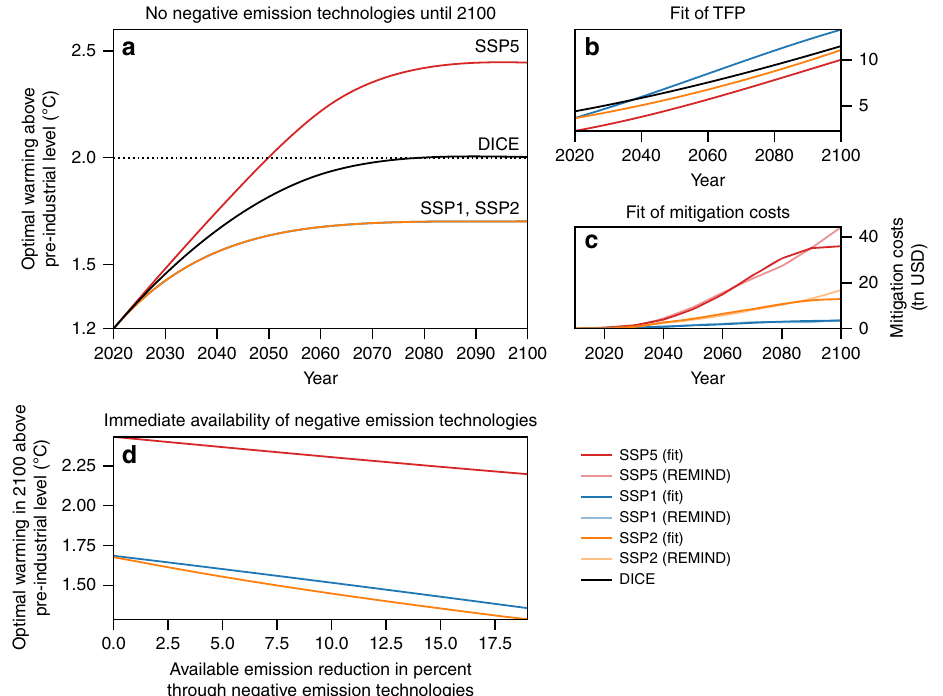
Fig. 6 Economically optimal warming for SSP1, SSP2, SSP5 and DICE. a The economically optimal temperature pathway for different socioeconomic conditions under the assumption that negative-emission technologies are not used within this century. b , c Recalibrated parameters in DICE to match the results of the REMIND model for the three SSPs. b shows the results for the total factor productivity (TFP) and c for the costs of mitigation. d Economically optimal warming in 2100 if negative-emission technologies are available in this century.